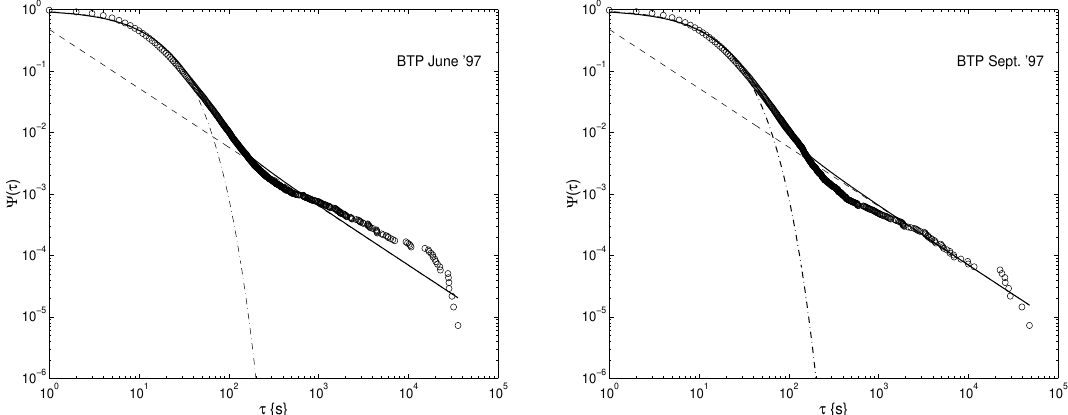
Figure 2. Survival probability for BTP futures with delivery date: June 1997 ( left ) September 1997 ( right ). The Mittag-Leffler function (solid line) is compared with the stretched exponential (dash-dotted line) and the power (dashed line) functions: { β = 0.96, γ = 1/13} ( left ); { β = 0.96, γ = 1/13)} ( right